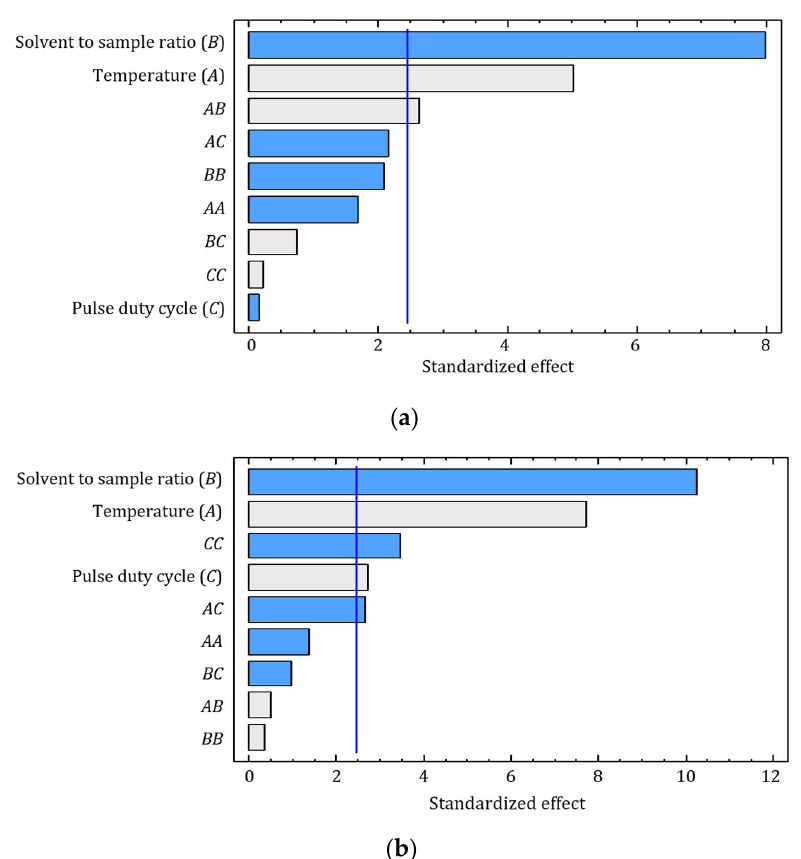
Figure 1. Pareto chart of UAE factors and their effects ( A , extraction temperature; B , solvent ‐ to ‐ sam ‐ ple ratio; C , pulse duty cycle) on antioxidant activity ( a ) and total phenolic content ( b ). The vertical lines that cross the bars indicate that the corresponding factor has a significant effect with 95% con ‐ fidence in the response. The bar colors of and indicate positive and negative effects, re ‐ spectively.